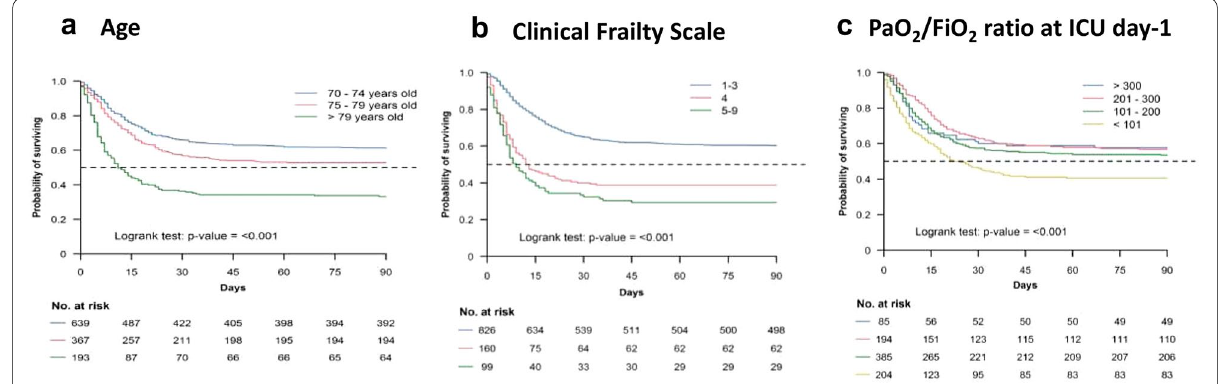
Fig. 2 Kaplan–Meier survival estimates during the 90 days following ICU admission, according to a age (70–74 years, 75–79 years and > 80 years), b Clinical Frailty Scale (1–3; 4; > 5) and c PaO 2 /FiO 2 ratio at Day-1 of ICU =